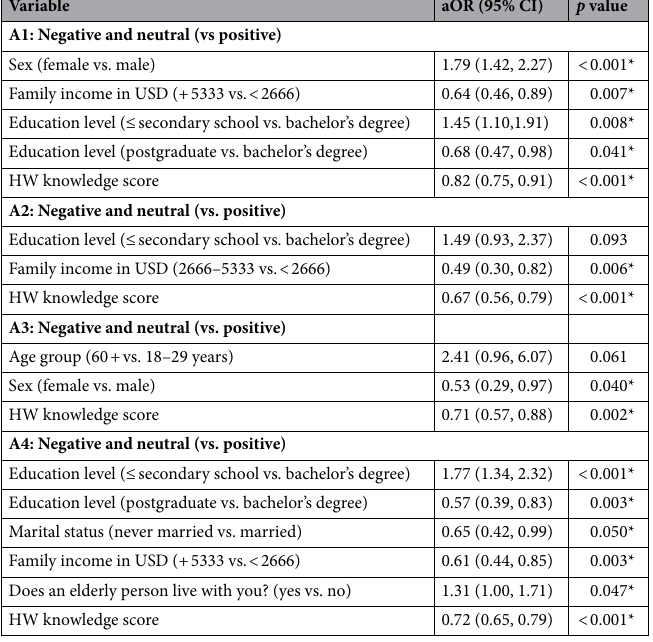
Table 5. Multiple logistic regression on factors associated with negative attitudes. *p <